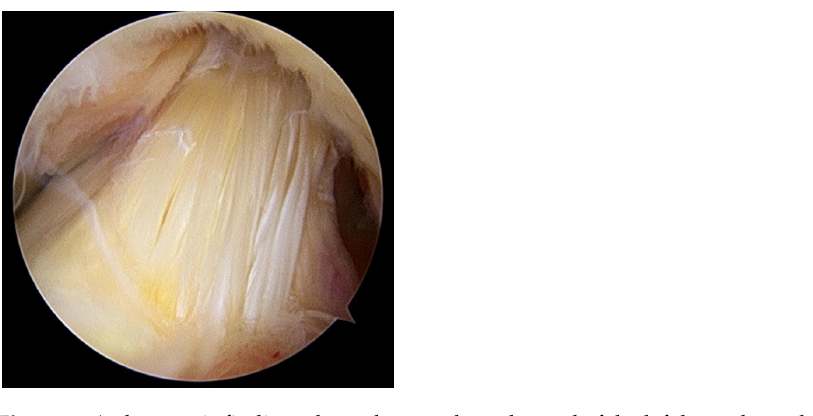
Figure 2. Arthroscopic findings through anterolateral portal of the left knee show absence of syn- ovial lining with longitudinal separation of the anterior cruciate ligament (ACL) bundles.